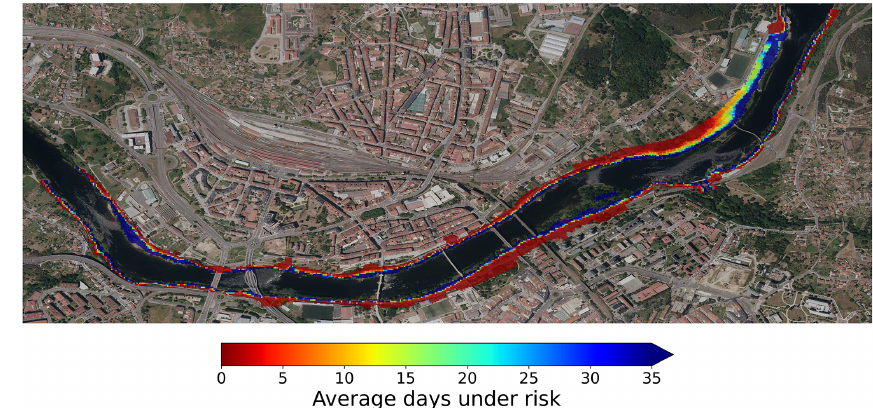
Figure 8. Multi-model mean of the number of days under hazard by floods for each pixel of the domain in the historical period. Only the area outside the riverbed was considered for the flood risk analysis (aerial picture courtesy of PNOA © Instituto Geográfico Nacional).